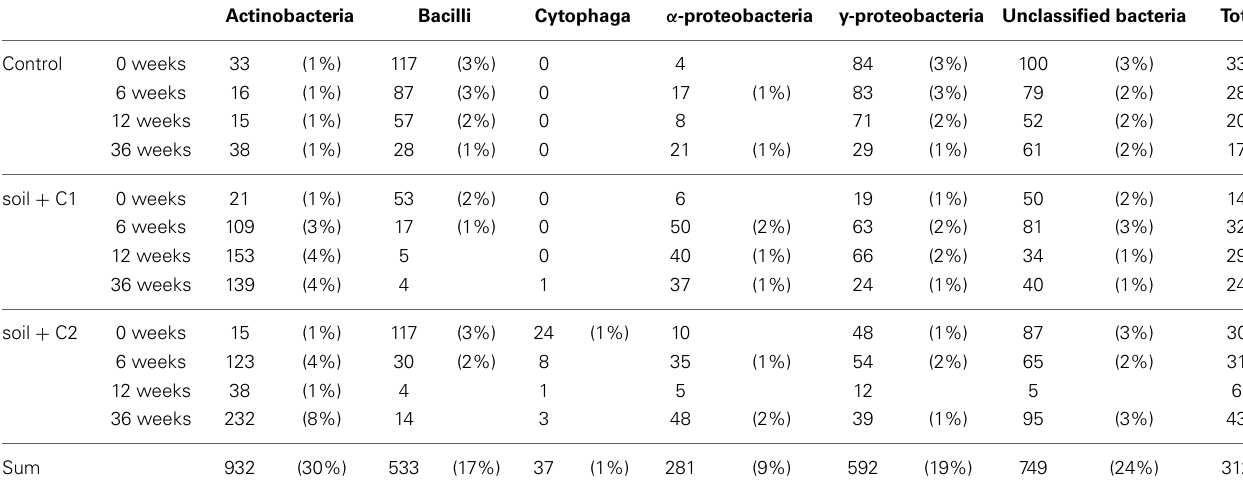
Table 2 | Distribution of alkB gene fragments over all samples.